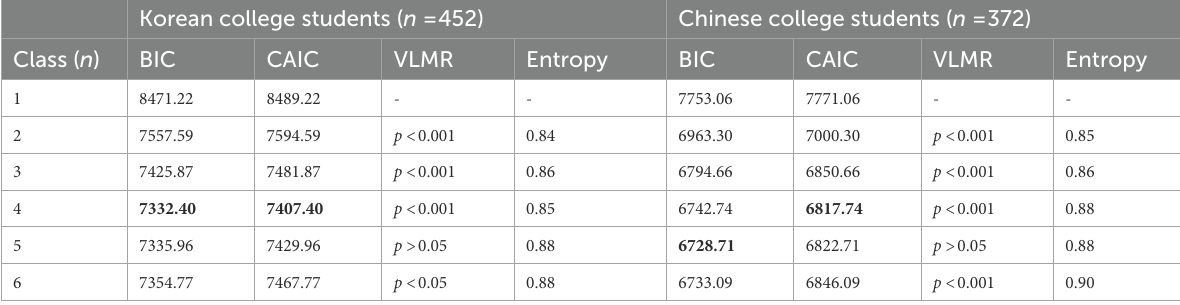
TABLE 3 Latent class analysis statistics and fit indices.